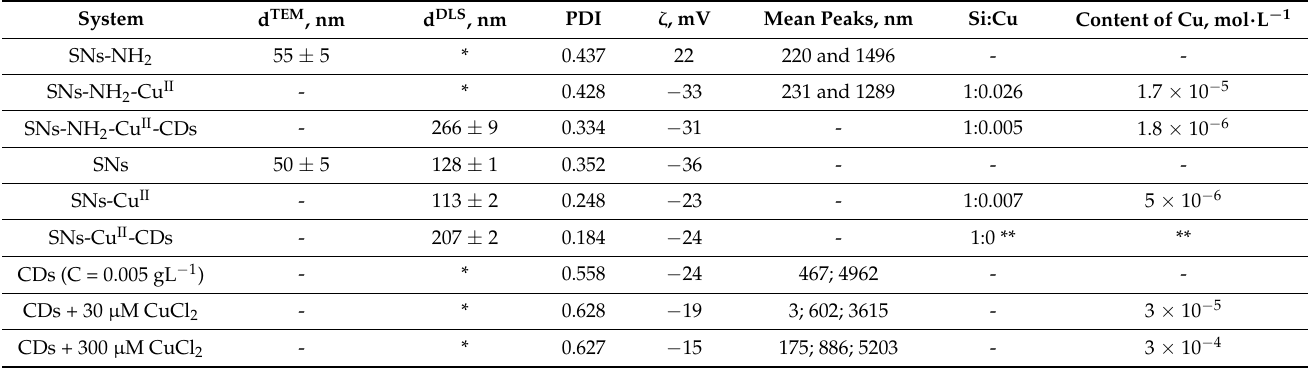
Table 1. Values of averaged diameter (d TEM ) evaluated by TEM method and averaged hydrodynamic diameter (d DLS ), polydispersity index (PDI), ζ -potential values and mean peaks (nanoparticle distri- bution by volume, instead of d DLS at PDI > 0.4) evaluated by DLS technique for different systems, as well as the content of Cu in nanoparticle dispersion (0.1 gL − 1 ) and Si to Cu molar ratio obtained by ICP-OES